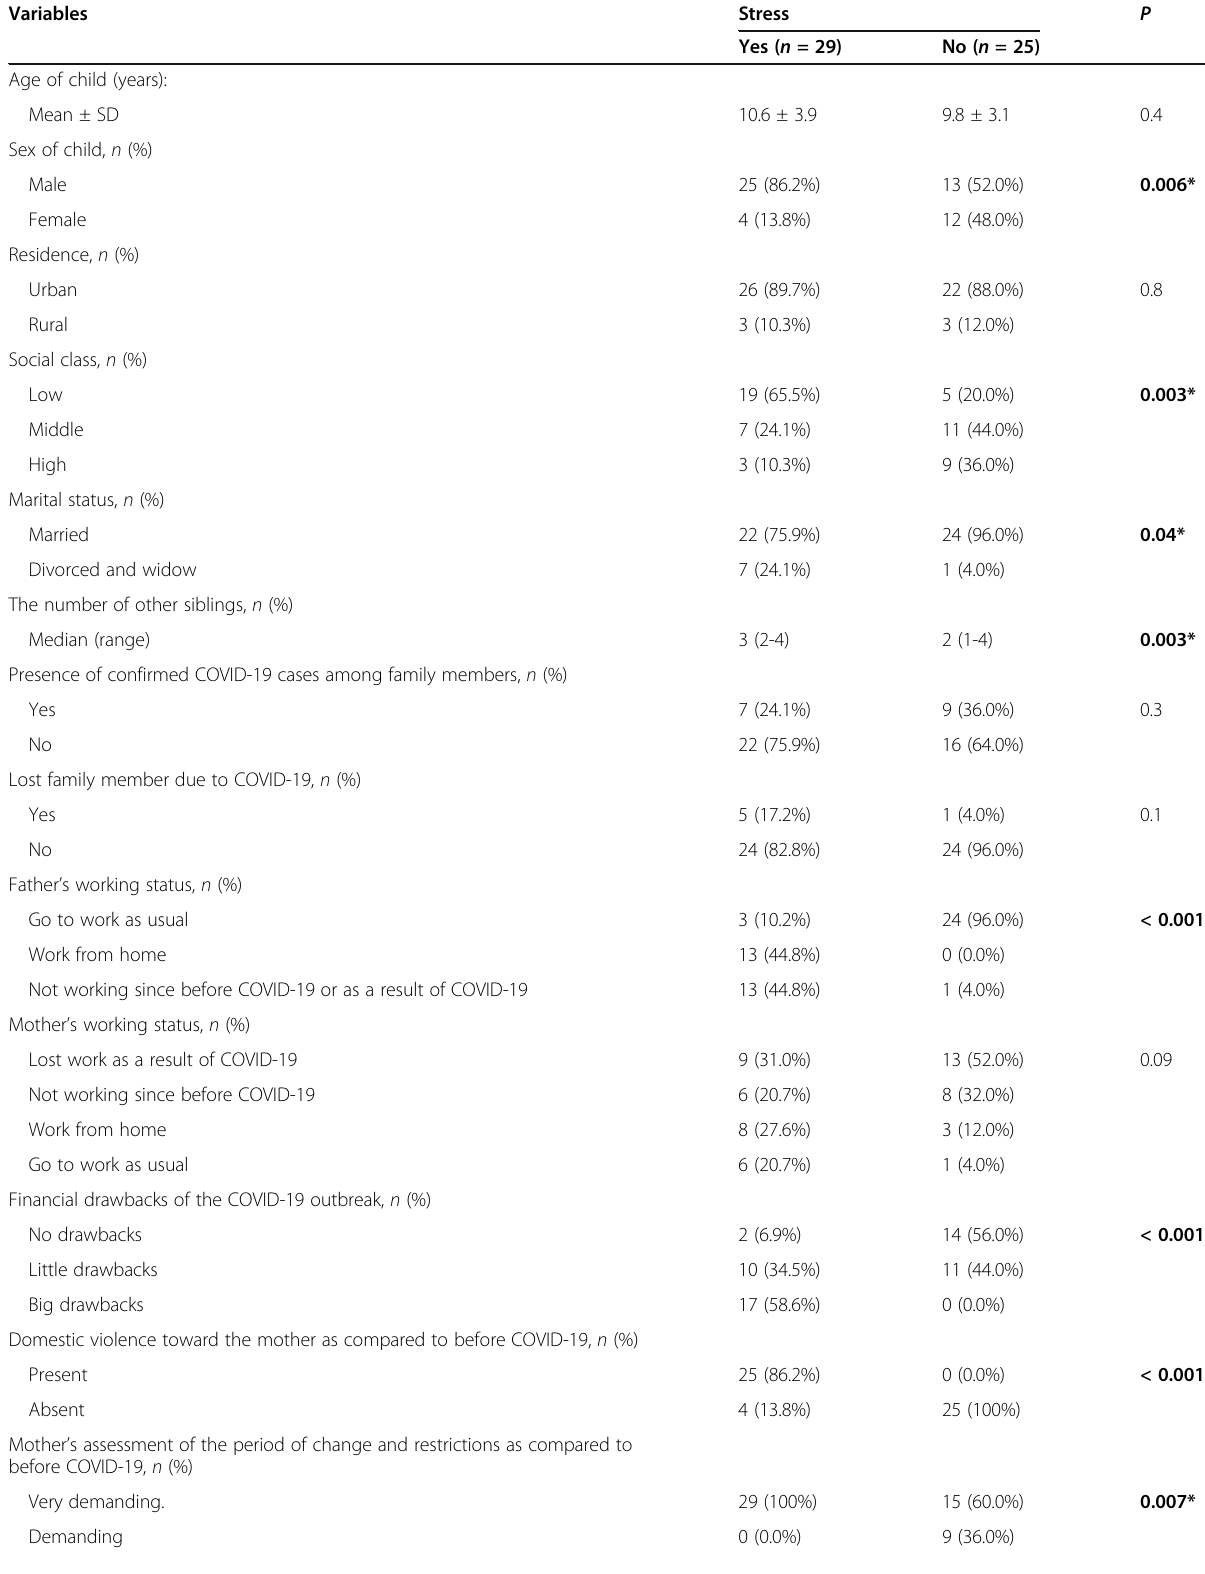
Table 5 Association between stress and other characteristics in mothers of ADHD children